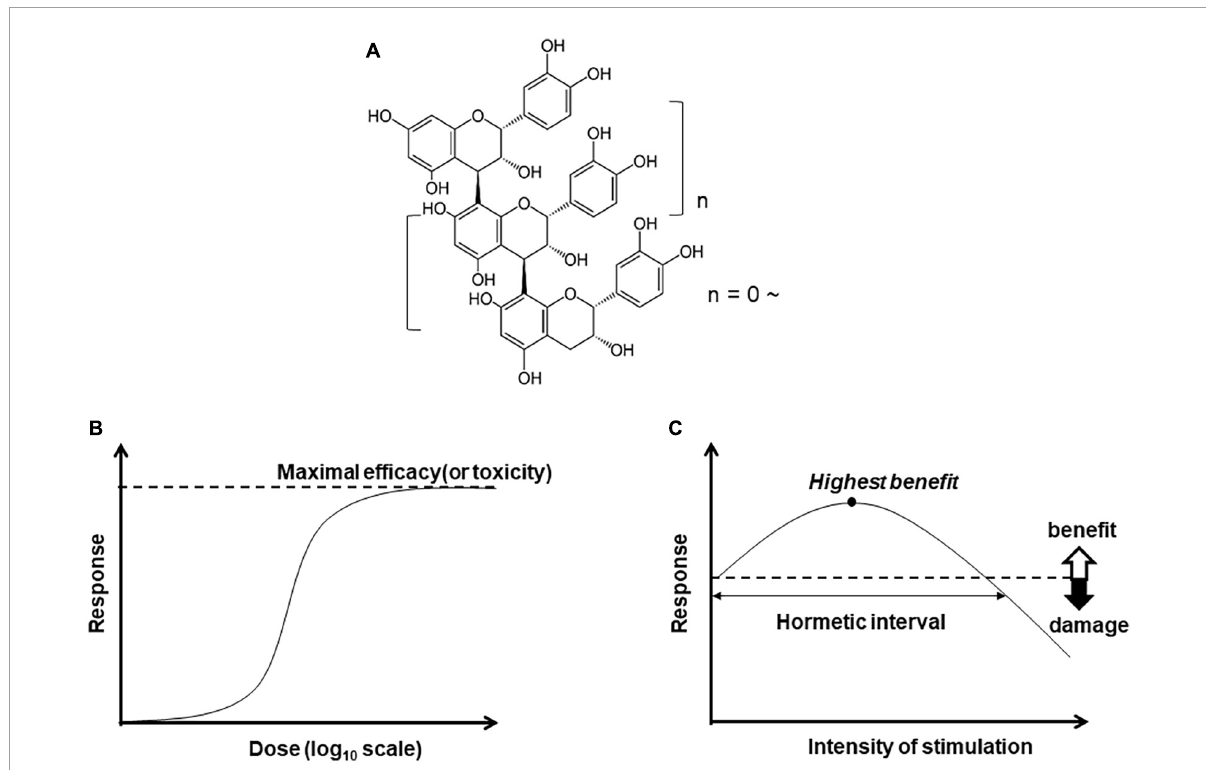
FIGURE1 Chemical structure of B-type procyanidin (C4–C8) bond, (A) , and dose-response curves: (B) monotonic and (C)